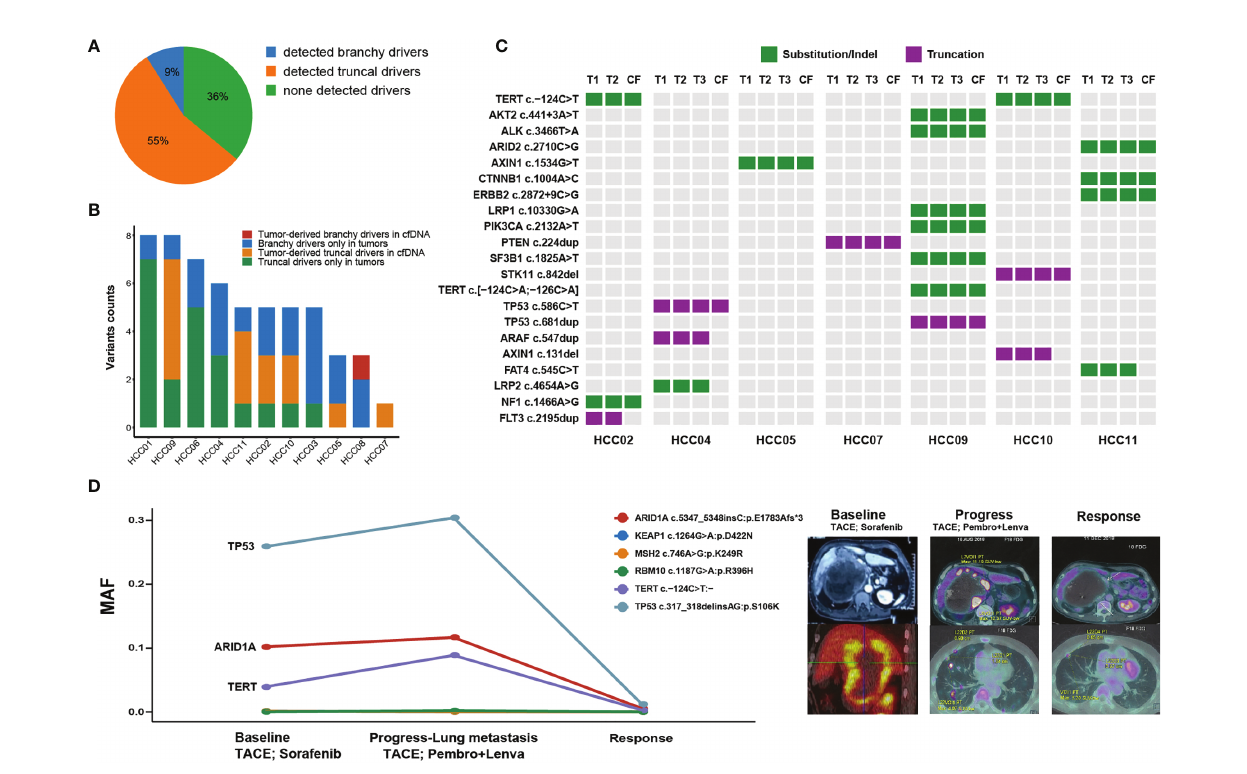
FIGURE 3 | Overview of altered putative HCC driver mutations uncovered through circulating-free DNA (cfDNA). (A) The proportion of cfDNA-capturing tumor- derived driver mutations in 11 multifocal HCC patients. (B) The absolute counts of somatic HCC driver mutations that are simultaneously or independently captured by tumor tissues and cfDNA. (C) The distribution of HCC driver mutations that were mutant in at least one foci of each patient which partly presented in circulating- free (CF) samples. (D) Longitudinal tracking of tumor progression and therapeutic response by cfDNA to pembrolizumab plus lenvatinib in one patient with metastatic HCC. The line chart shows the mutational allele frequencies (MAFs) of major driver mutations in cfDNA which occurred at the time of baseline, disease progression with emerging lung metastasis, while almost absented at the time of objective